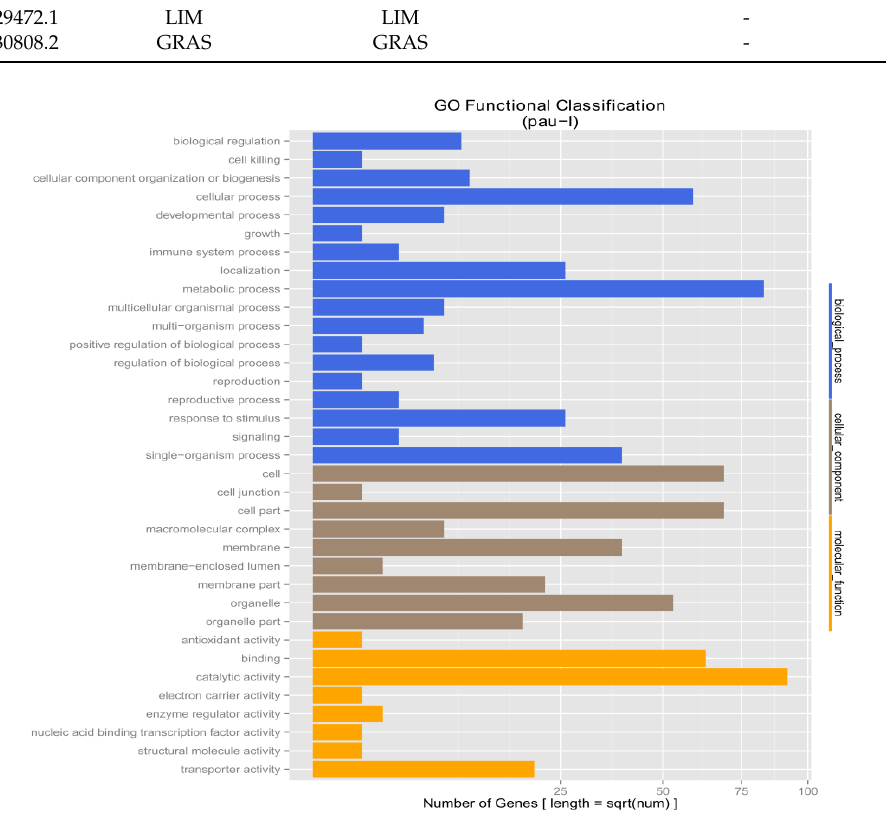
Figure 3. Gene Ontology (GO) for the co-expressed DEGs in two P. fortu nei genotypes.